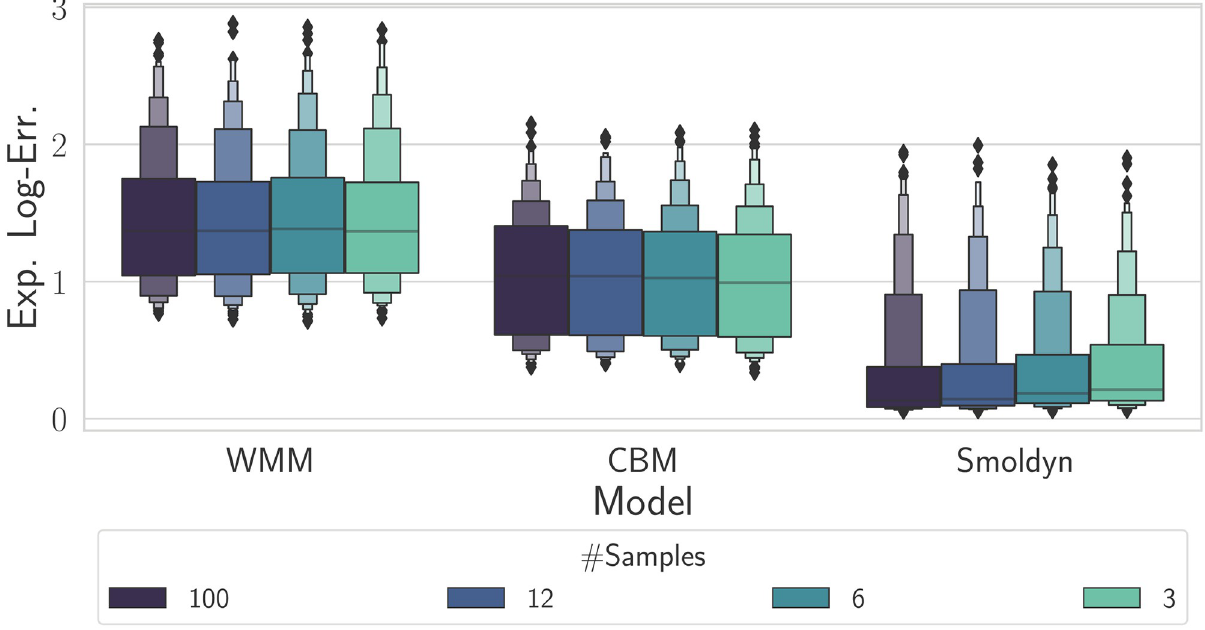
Fig 6. Boxen plots of expected log-error based on the Kolmogorov distance when increasing the number of time samples from 3 to 100. The colour of the boxen plot corresponds to the number of time samples used, with the lighter the colour corresponding to fewer time points. The error only decreases substantially when Smoldyn is used, suggesting model error is the limiting factor in the case of the WMM and the CBM.